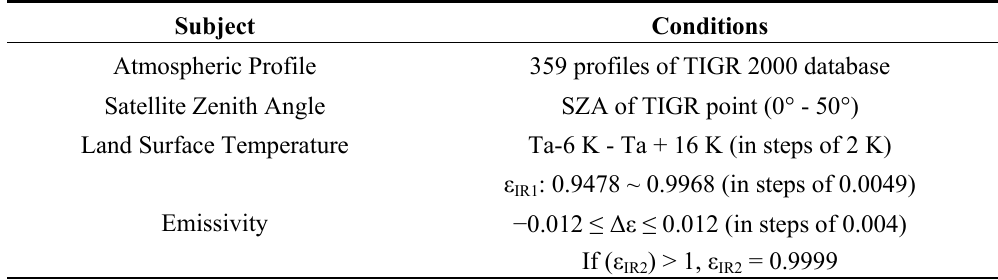
Table 2. Atmospheric, surface and sensor-target conditions used in radiative transfer model simulations. SZA, satellite zenith